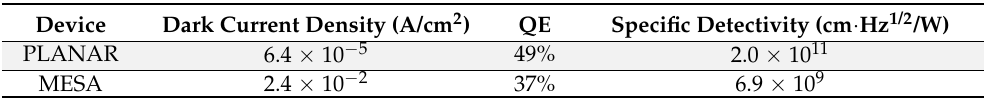
Table 1. Performance comparison between the planar MWIR photodetector and mesa-isolated photodetector at 150